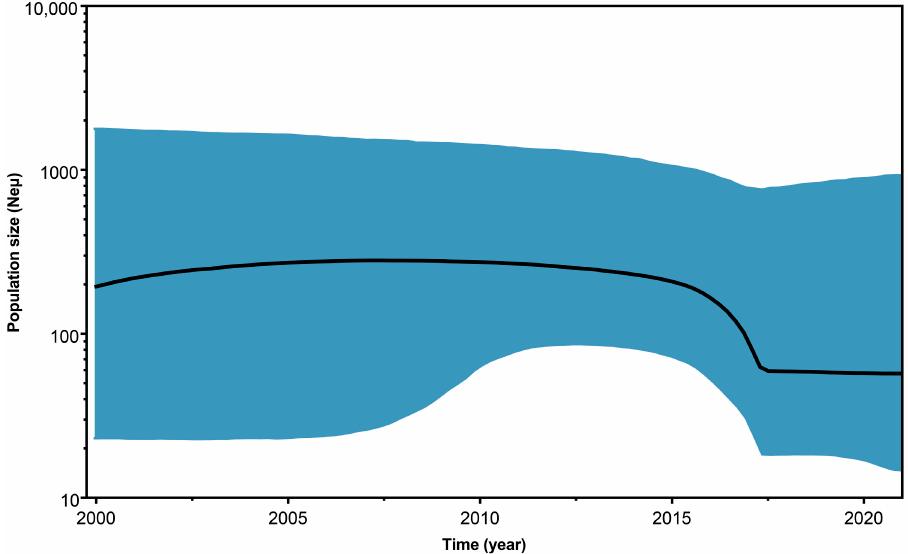
Figure 3. Bayesian skyline plot representing the demographic history of babaco mosaic virus from 2000 to 2021. The black solid line indicates the median population size, and the 95% highest posterior density limits are shown by the blue area. Ne μ (effective population size × mutation rate per site per generation).